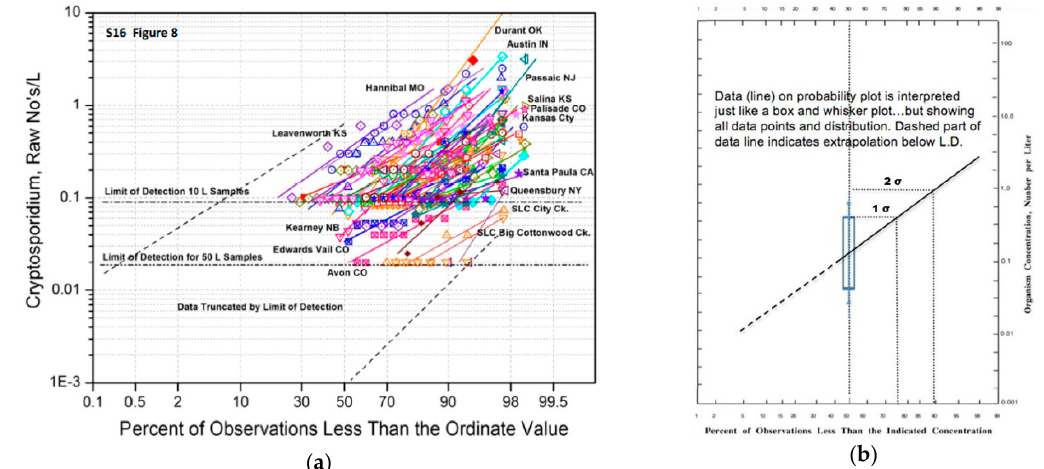
Figure 4. Cumulative frequency distribution illustrations: ( a ) Cryptosporidium oocysts in monthly surface water samples for PWS serving >10,000 pop. 150 of 1670 USA locations required by the USEPA [2]; and ( b ) basic features of a cumulative frequency plot of typically log-normally distributed data showing the two key features: (1) 50%ile or median level; and (2) slope…measure of the standard